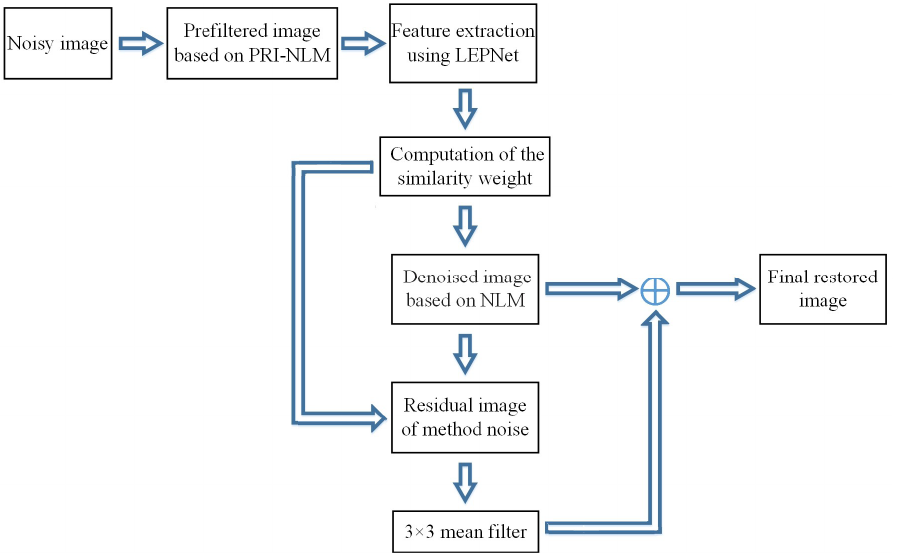
Figure 3. Block diagram of the proposed denoising method.